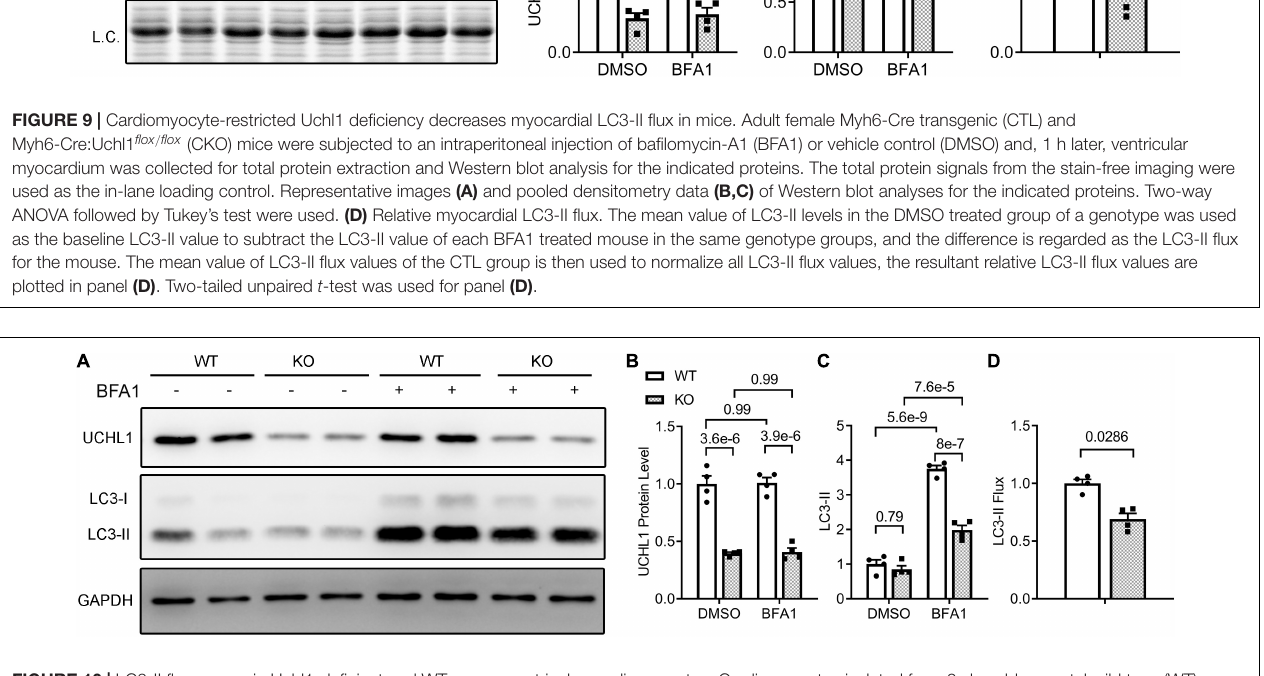
FIGURE 10 | LC3-II flux assays in Uchl1-deficient and WT mouse ventricular cardiomyocytes. Cardiomyocytes isolated from 2-day old neonatal wild type (WT) or homozygous Uchl1-floxed (KO) mice were cultured for 48 h before infected with adenoviral vectors expressing the Cre recombinase (ad-Cre). Twenty-four hours later, these cells were treated with bafilomycin A1 (BFA1; 6 nM) or vehicle control (DMSO) for 24 h before they were harvested for total protein extraction. Representative images (A) and pooled densitometry data (B,C) of the Western blot analyses for the indicated proteins. (D) Relative LC3-II flux derived from the LC3-II flux assays. Related calculation and statistic methods are identical to what described in Figure 9